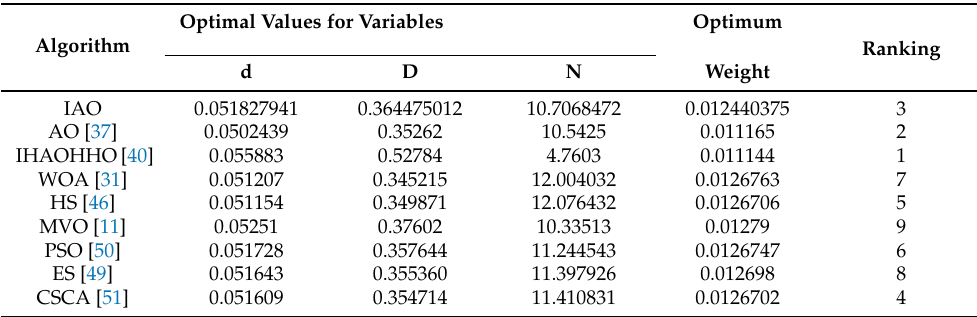
Figure 8. Tension/compression spring design problem. Table 15. Results of the compared algorithms for solving the tension/compression spring design